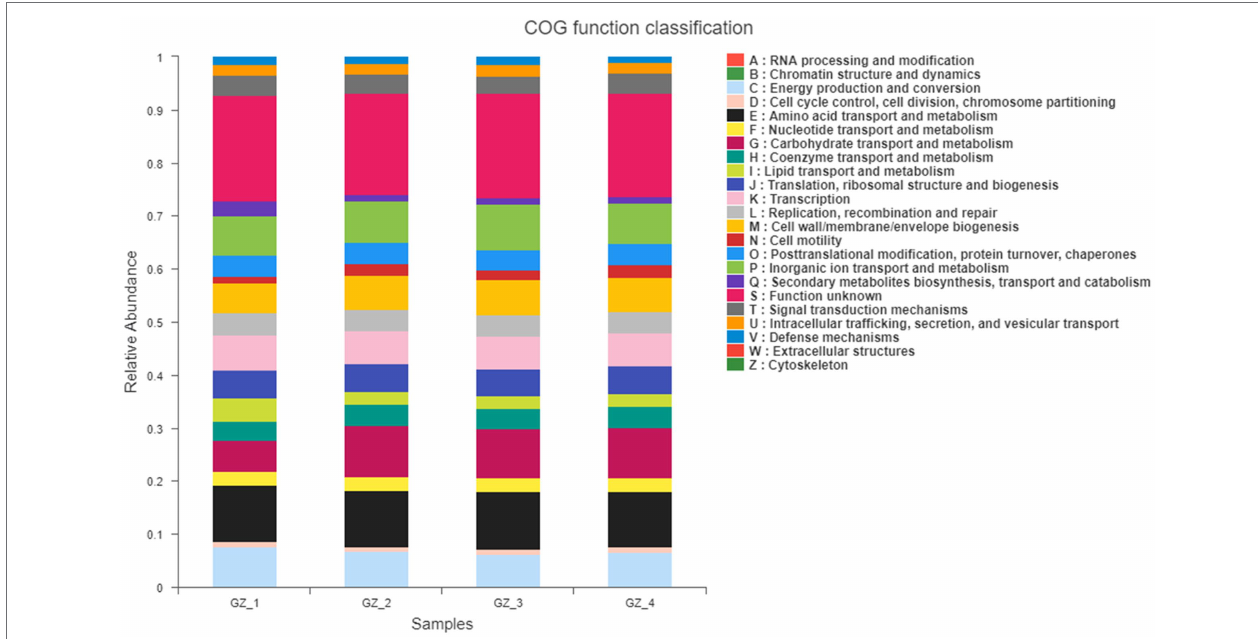
FIGURE 3 | COG function classification statistical histogram (The x -axis is different groups. GZ_1: fresh licorice; GZ_2: early drying-6 days after drying; GZ_3: mid- drying-12 days after drying; and GZ_4: completely drying-after 18 days. The y -axis is the relative abundance of